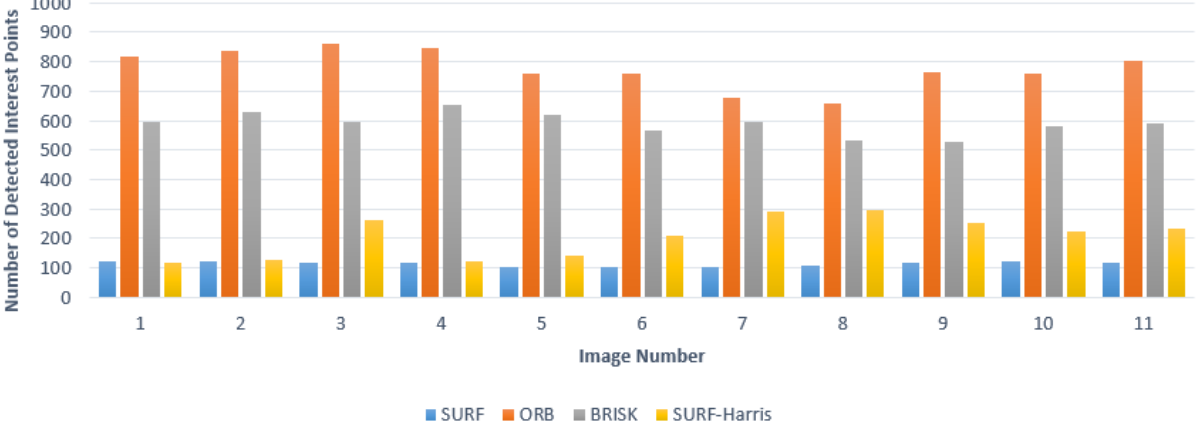
Figure 18. Total number of detected interest points by each algorithm in each image of dataset 2.